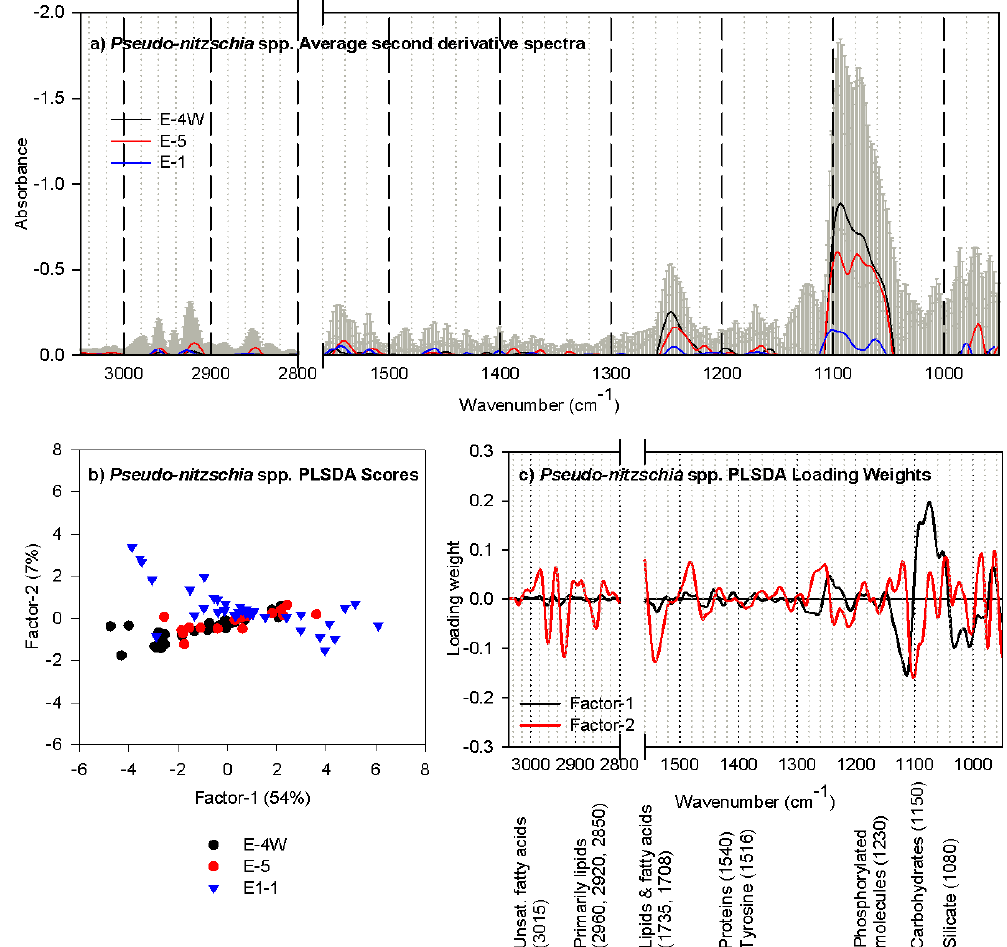
Figure 6. Average second-derivative spectra (a) , PLSDA score plot (b) and PLSDA loading-weights plot for Pseudo-nitzschia spp. at stations E-1, E-5 and E-4W. Although the average second-derivative spectra show differences between treatments, intra- and interspecific variability are both high, resulting in weak clustering by station in the score plot. The loading-weights plot shows that variability between cell spectra is largely driven by protein levels ( ∼ 1540cm − 1 ) , carbohydrates (1150cm − 1 ) and silicate/silicic acid (1080cm − 1 )